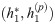
Comparison of hierarchies for twitter-like RSBMs.The parameters are p = q = 0.5, R = 32, s varies in [0, smax], with smax = 0.448. Each point refers to a single realisation of the ensemble. The circles represent the pairs (h1*,h1(p)), i.e. the optimal hierarchy h1* computed with agony and the one of the planted hierarchy h1(p). The stars represent (h1*,h¯1*) where h¯1* is the theoretical hierarchy of Eq (8) with the parameters of the SBM estimated via GraphTool. Finally, sm is the theoretical resolution threshold and sh¯(p)=0 is the theoretical value of s for which the estimate for the planted hierarchy is zero.